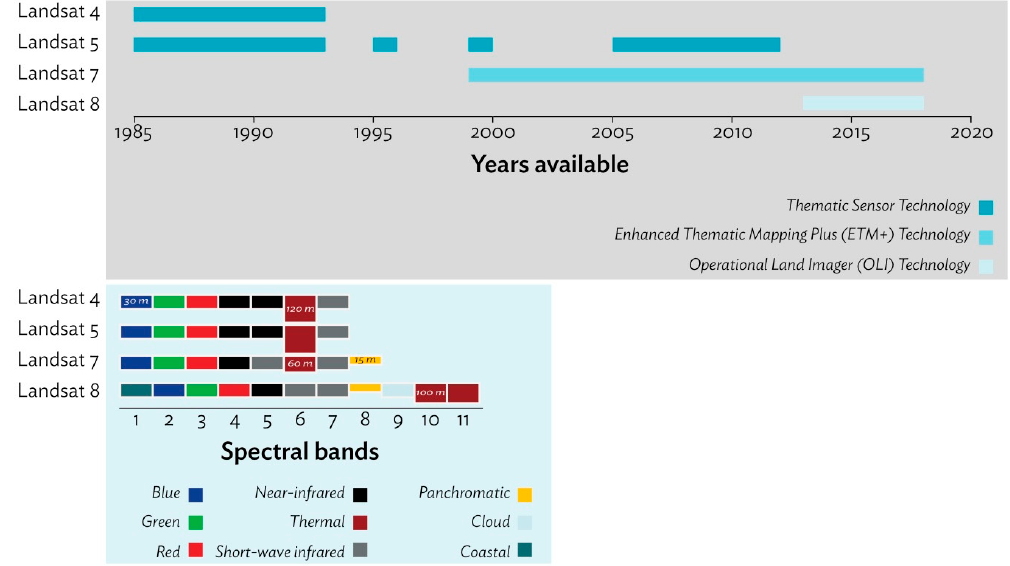
Figure 2. Landsat missions years of availability in Gates of the Arctic National Park and Preserve (GAAR); satellite payload sensor technologies; spectral bands; pixel spatial scales of each band analyzed in this